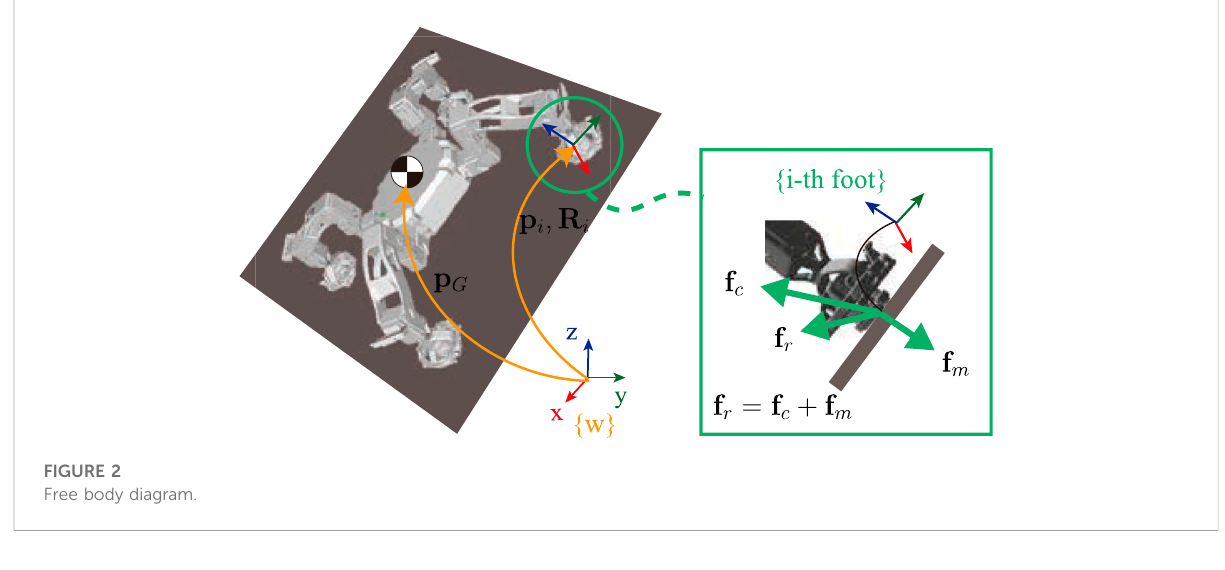
FIGURE 2 Free body